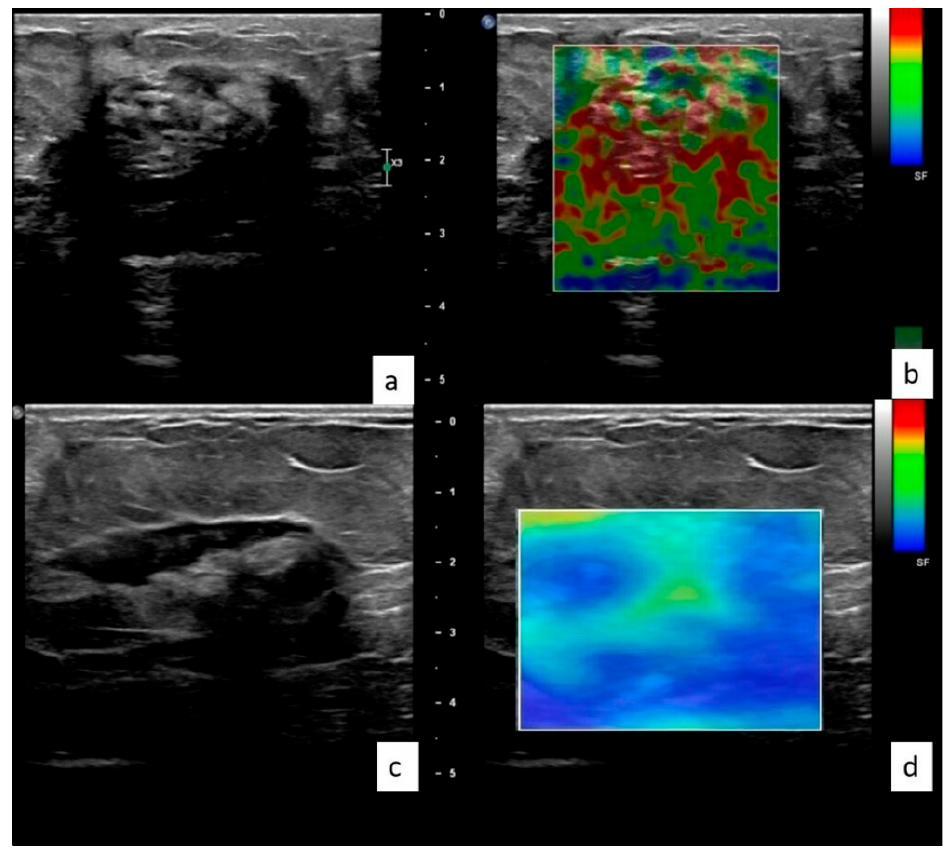
Figure 2. 38 year old female with pathologically confirmed granulomatous mastitis. The lesion was located on the right breast, upper quadrant. The patient was treated locally. Elastographic examinations at the time of diagnosis ( a , b ) and 8 weeks after treatment ( c , d ) reveal that the lesion’s elasticity value (kPa) decreased by 57.9%, from 77.5 to 32.6 kPa.